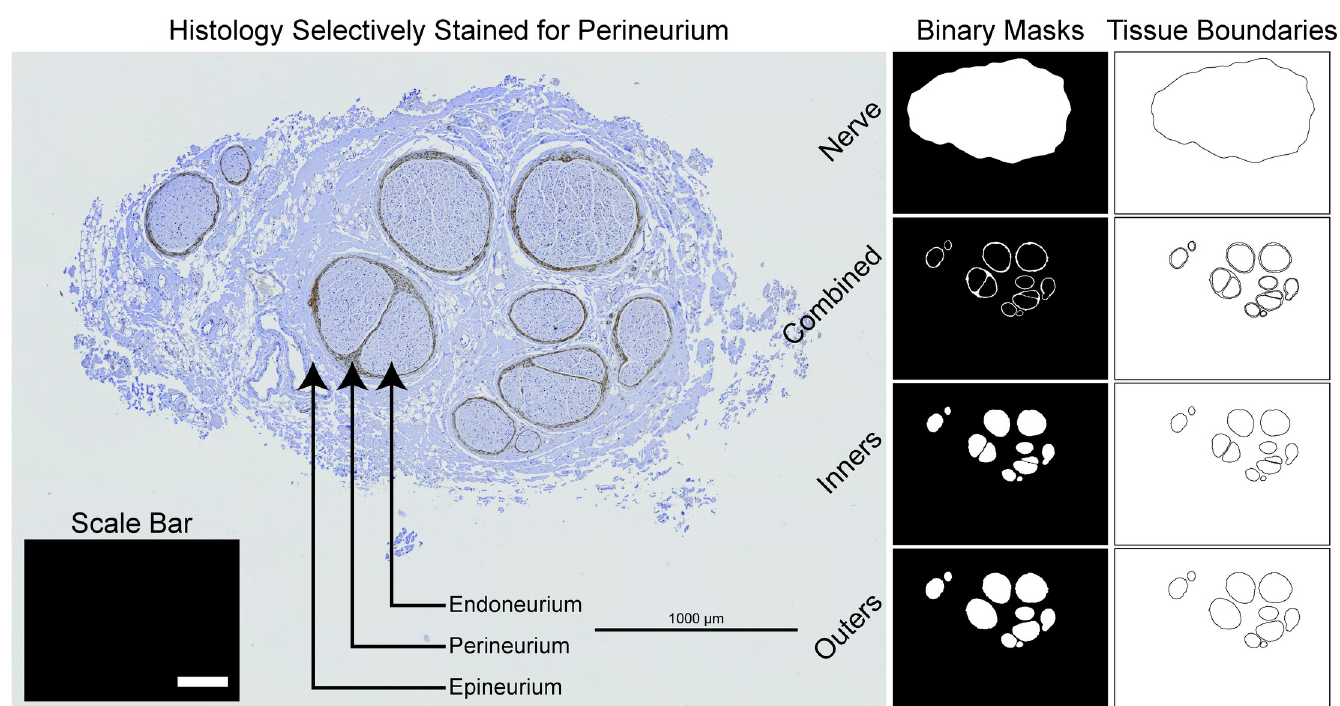
Fig 2. Define sample-specific models with segmented nerve images. We segmented the nerve boundary (n.tif), the perineurium (either “Combined” (c.tif), or both “Inners” (i.tif) and “Outers” (o.tif), or only “Inners”), and a horizontal “Scale Bar” (s.tif) of known length from a micrograph of a human cervical vagus nerve stained selectively for perineurium. In this example, two fascicles have multiple inner traces for their single outer trace (i.e., “peanut” fascicles), which requires their perineurium to be meshed; conversely, the other fascicles have a single inner trace for each outer trace, in which case the perineurium can be either meshed or modeled with a thin layer approximation. The nerve cross section is modeled in the (x,y,0) plane and extruded into the +z direction for the length of the nerve.